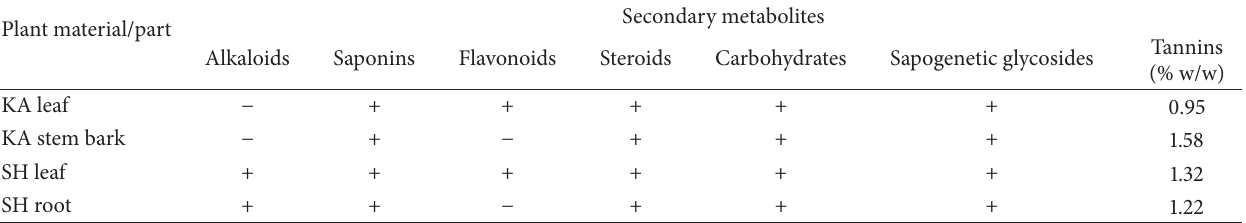
Table 1: Preliminary phytochemical screening of dried leaves and stem barks of K. africana (KA) and S. hispidus (SH). Plant material/part